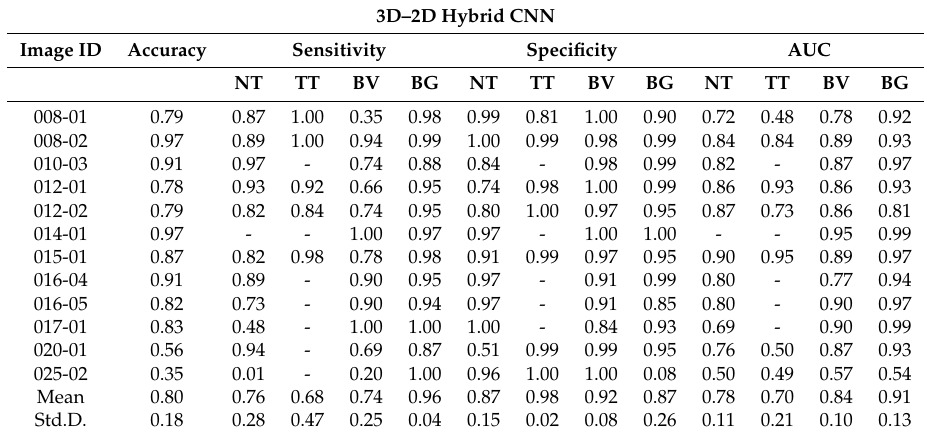
Table A1. Overall results for the 3D–2D hybrid CNN. Accuracy, sensitivity, specificity, and AUC are calculated for each class. NT: Normal tissue, TT: Tumor tissue, BV: blood vessels, BG: Background.